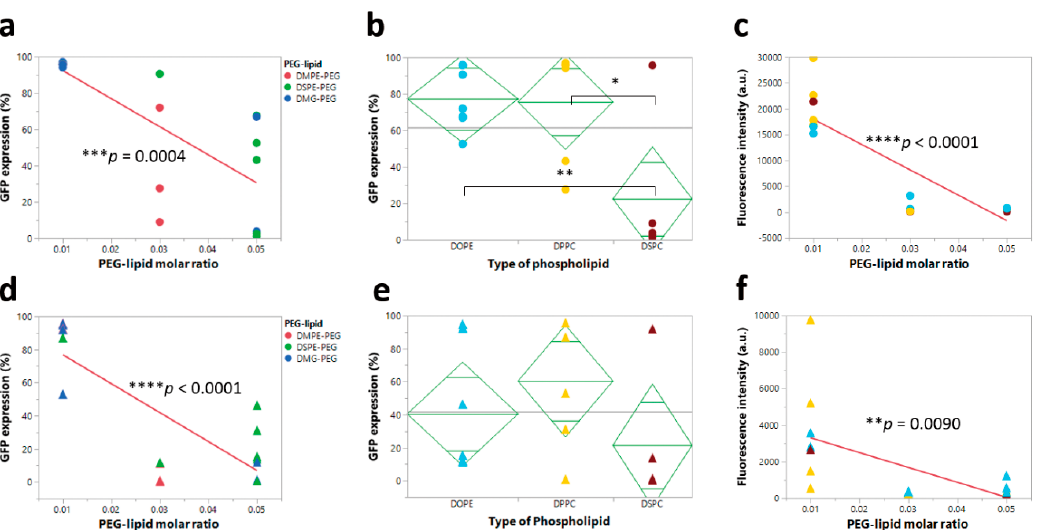
Figure 7. Correlation analysis between intracellular protein expression (percent GFP expression and fluorescence intensity) and PEG-lipid molar ratio or type of phospholipid. ( a ) Significant effect of PEG-lipid molar ratio on percent GFP expression before nebulization. ( b ) Significant effect of type of phospholipid on percent GFP expression before nebulization. ( c ) Significant effect of PEG-lipid molar ratio on fluorescence intensity before nebulization. ( d ) Significant effect of PEG-lipid molar ratio on percent GFP expression after nebulization. ( e ) No significant effect of type of phospholipid on percent GFP expression after nebulization. ( f ) Significant effect of PEG-lipid molar ratio on fluorescence intensity after nebulization. (* p < 0.05, ** p < 0.01, *** p < 0.001, and **** p < 0.0001)